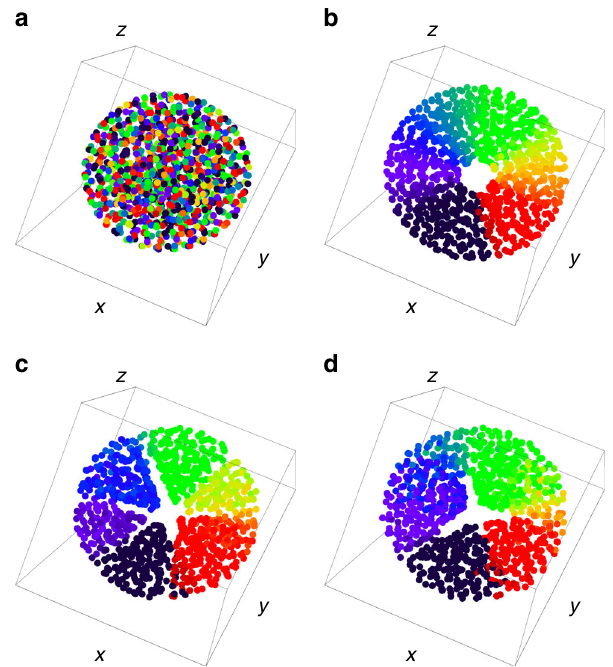
Fig. 9 Scatter plots in 3D. Four states in the ( x , y , z ) plane, where the swarmalators are colored according to their phase. Data were collected for J = 0.5 and N = 1000 swarmalators for T = 5000 time units with stepsize dt = 0.001 using Heun ’ s method. a Static async state for K = − 1. b Static phase wave for K = 0 c Splintered phase wave for K = − 0.05. d Active phase wave state for K = − 0.6. Supplementary Movies 9 – 12 correspond to panels a –